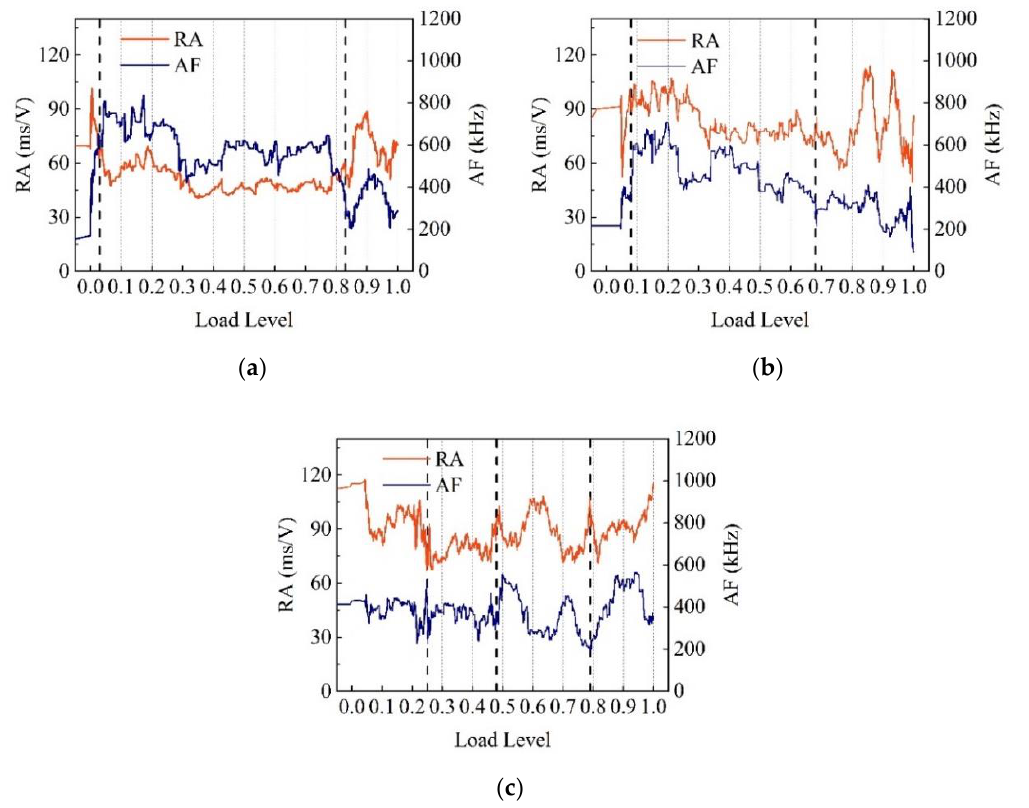
Figure 10. Moving average of RA and average frequency: ( a ) basalt fiber content of 6 kg/m³; ( b ) basalt fiber content of 10 kg/m³; and ( c ) basalt fiber content of 14 kg/m³.